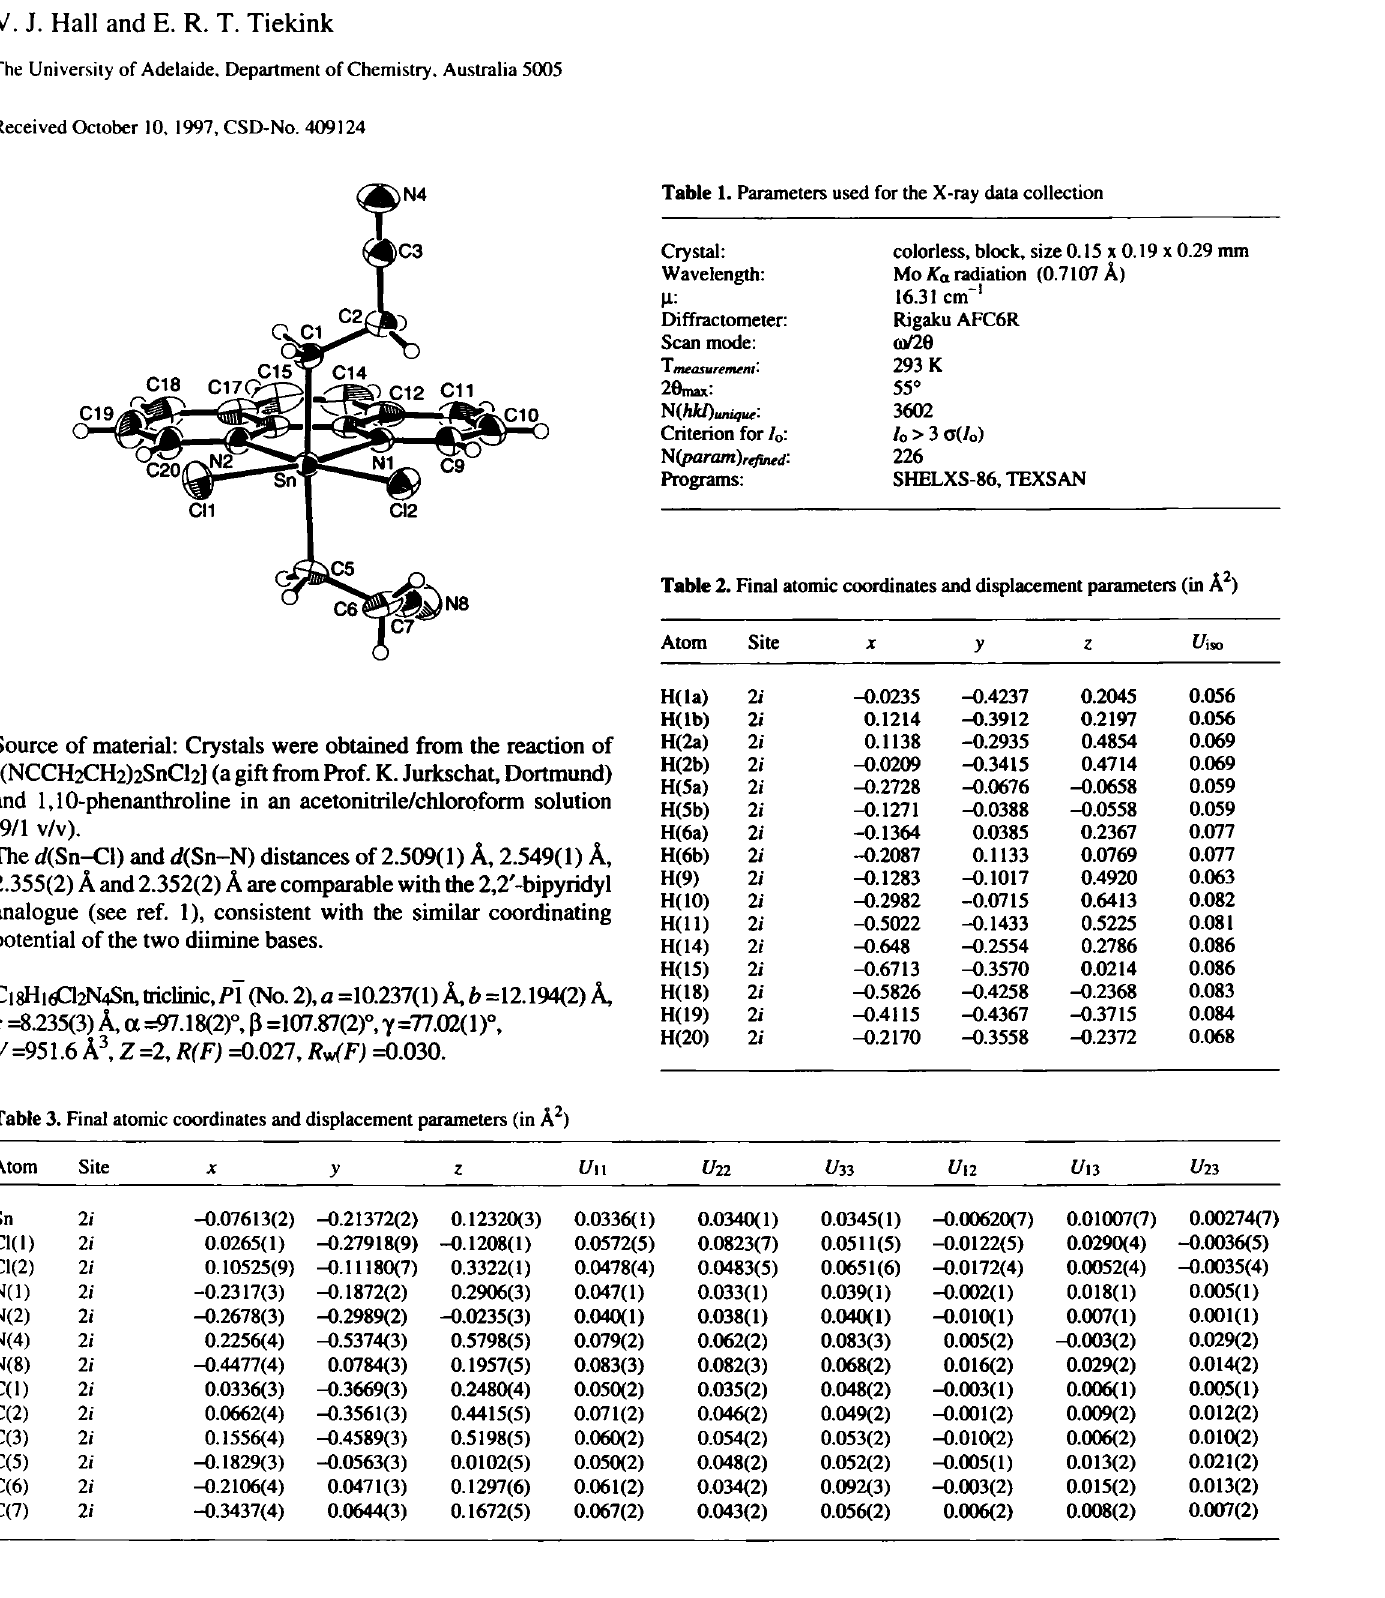
Table 1. Parameters used for the X-ray data collection Crystal: